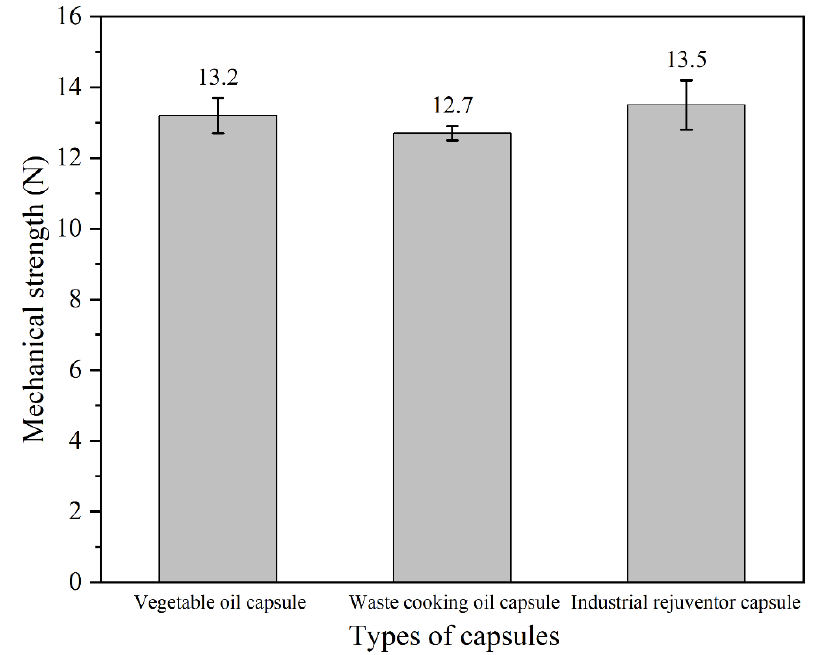
Figure 5. The mechanical strength of capsules containing different healing agent.